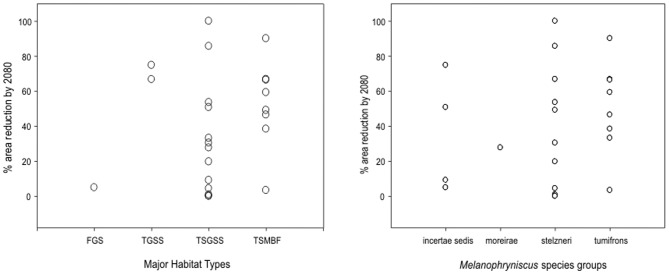
Reduction in climatic suitability area for Melanophryniscus species (2080) according to major habitat types in South America, and to phylogenetic groups.No significant differences were found in either situations (t-tests, TSGSS vs. TSMBF, p>0;19; stelzneri vs tumifrons, p>0.39). TSGSS, Tropical and Subtropical Grasslands, Savannas and Shrublands; TSMBF, Tropical and Subtropical Moist Broadleaf Forests.